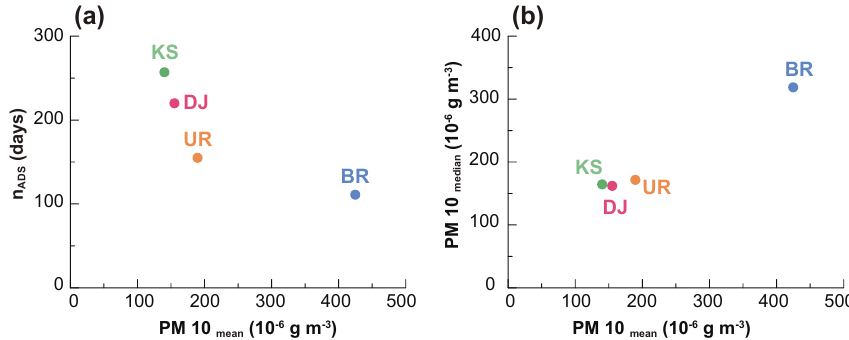
Figure 8. (a) An inverse correlation between ADS occurrence ( n ADS ) and annual mean PM 10 dust air concentration (PM 10mean ) . (b) A positive correlation between median PM 10 dust air concentration (PM 10median ) and annual mean PM 10 dust air concentration (PM 10mean )